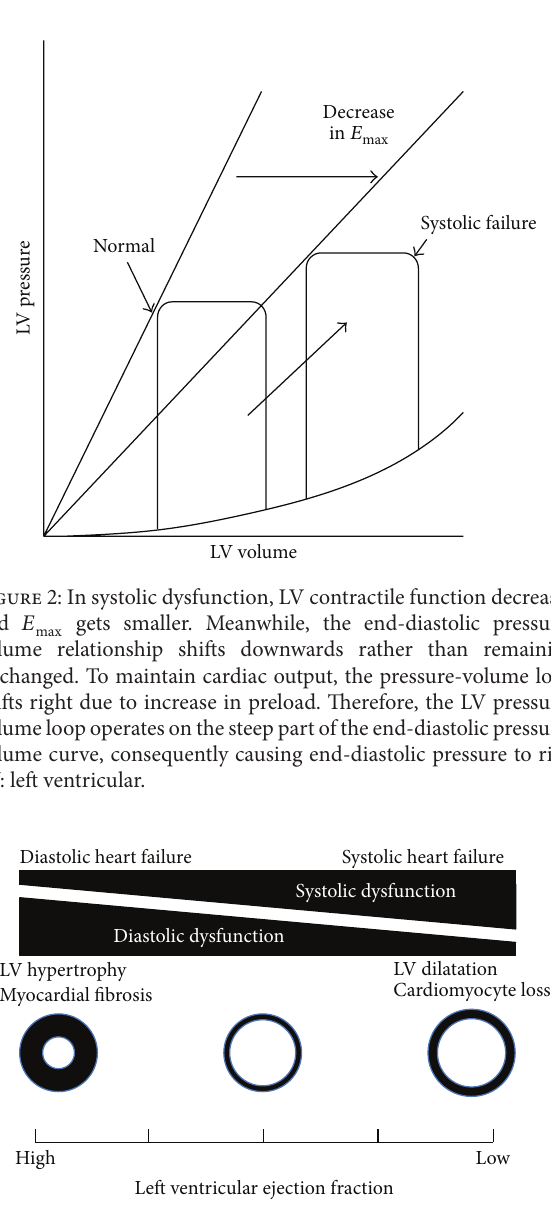
Figure 3: Diastolic and systolic heart failure are not considered to be independent and separate entities. Heart failure is a single continuous disease spectrum and systolic and diastolic heart failure are phenotypes at two